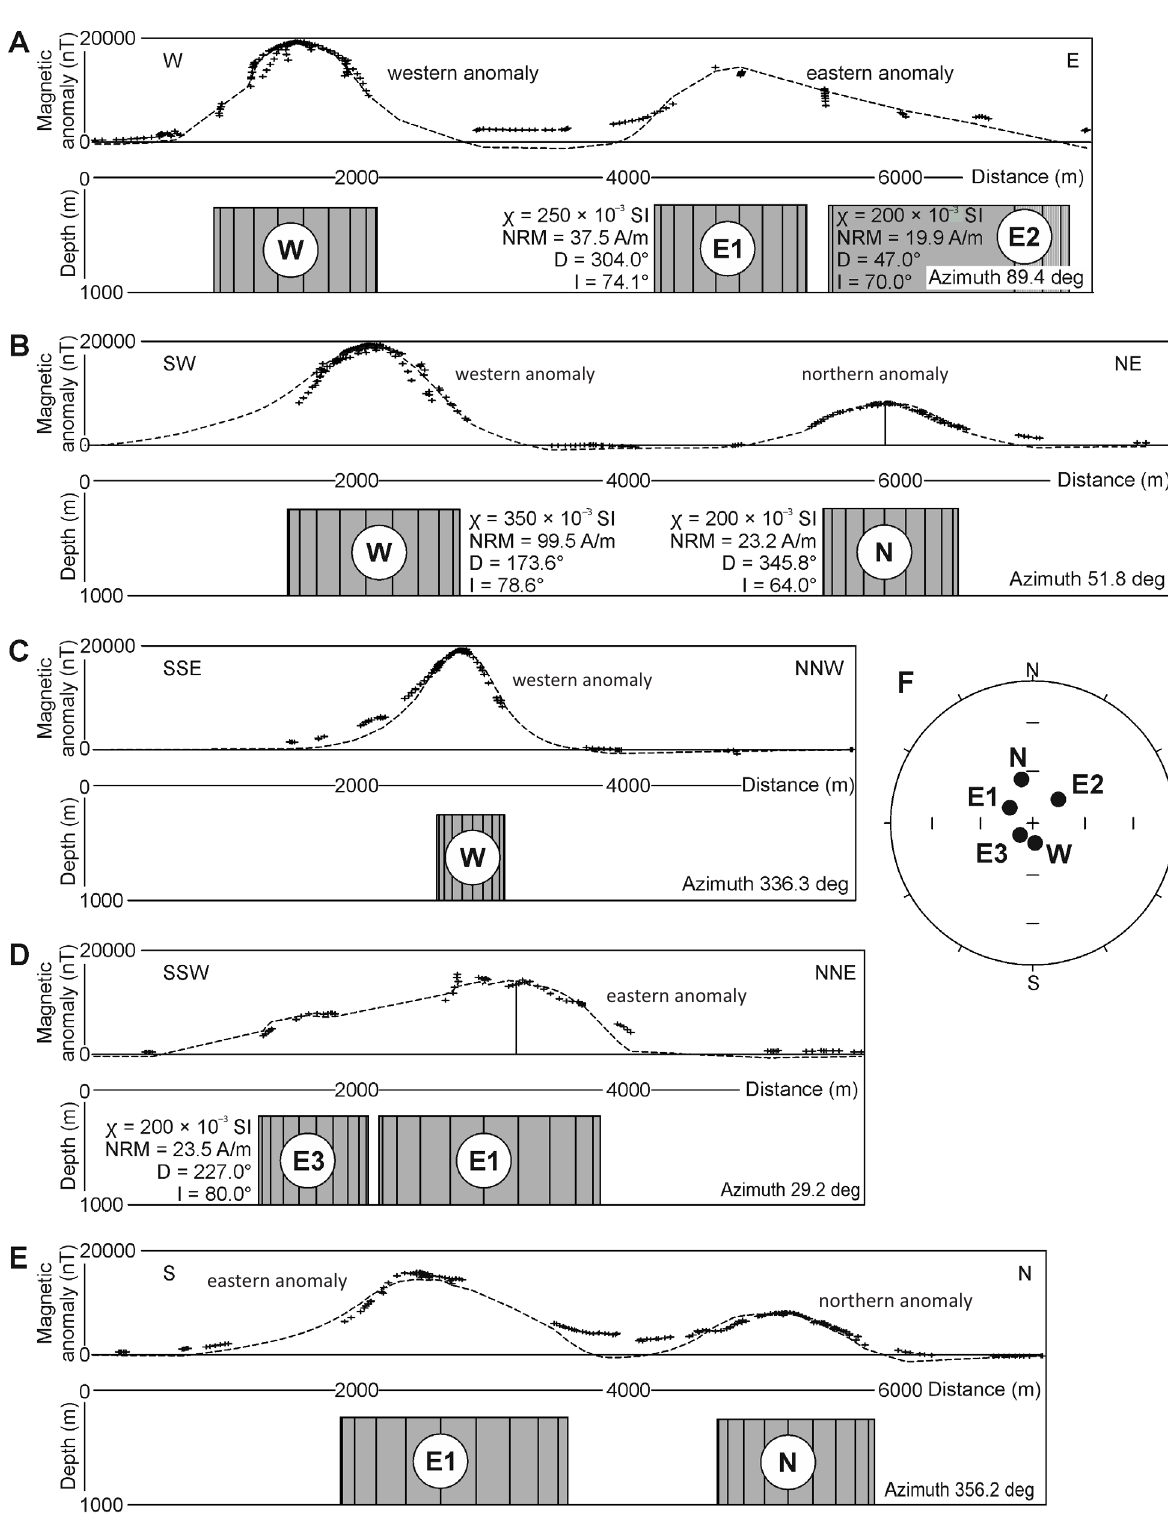
Fig. 3. A–E , cross sections of elliptic cylinders (E1, E2, E3, W, N and E, grey areas) along five profiles (see Figs 1B, 4 for location). The response curve is given (dashed line) and measured in the field original values (black + symbols). F , an equal area stereoplot to illustrate the declination and inclination of natural remanent magnetization by individual cylinders. The vectors point